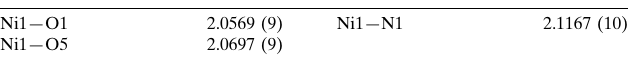
Selected bond lengths (A˚ ).